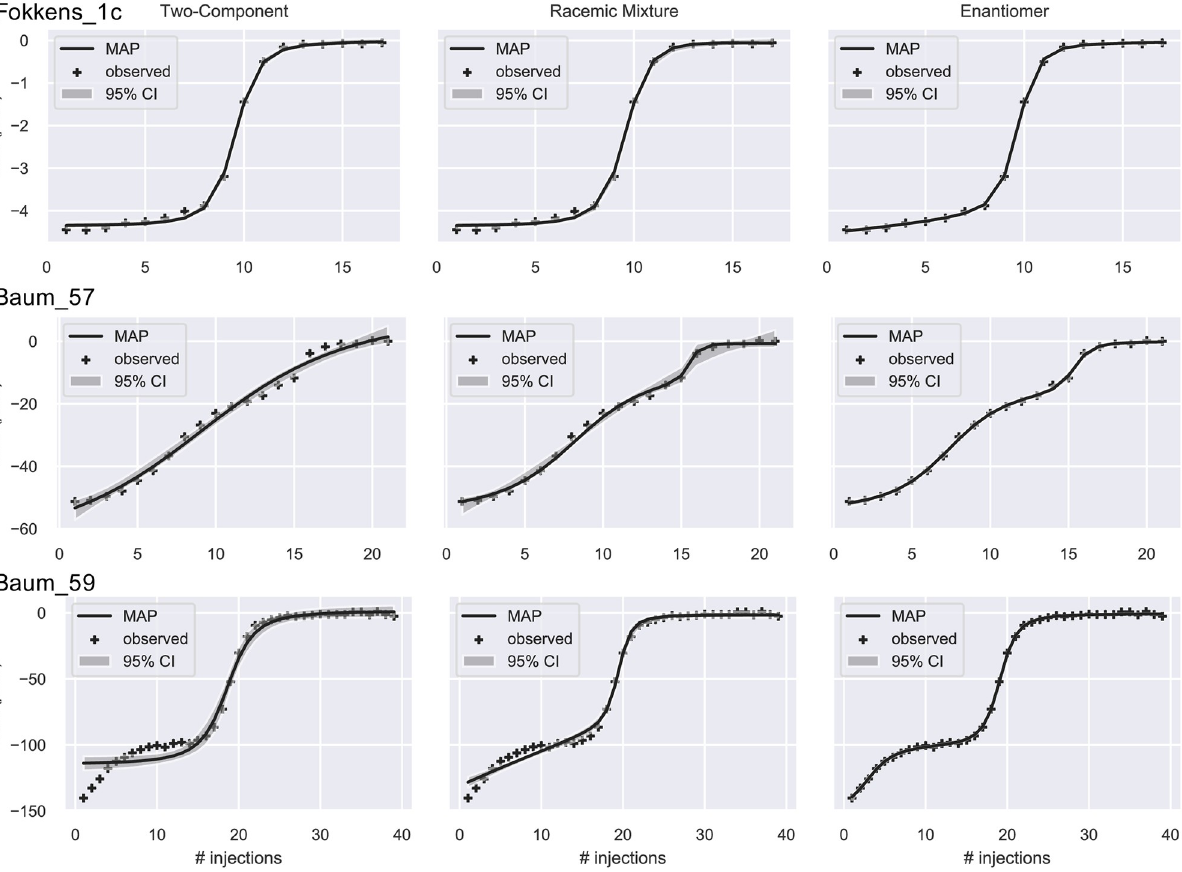
Fig 6. Integrated ITC heat data and their fit. The data were fitted by the 2C (left), RM (middle), and EM (right) models. The solid line is the theoretical heat q � ð θ Þ , where θ MAP is the Maximum a Posteriori estimate of the parameters. The grey band is the 95% confidence interval. Crosses MAP n are the observed heat. The three datasets are best fitted by the EM model according to the estimated Bayes factors (Table 3).